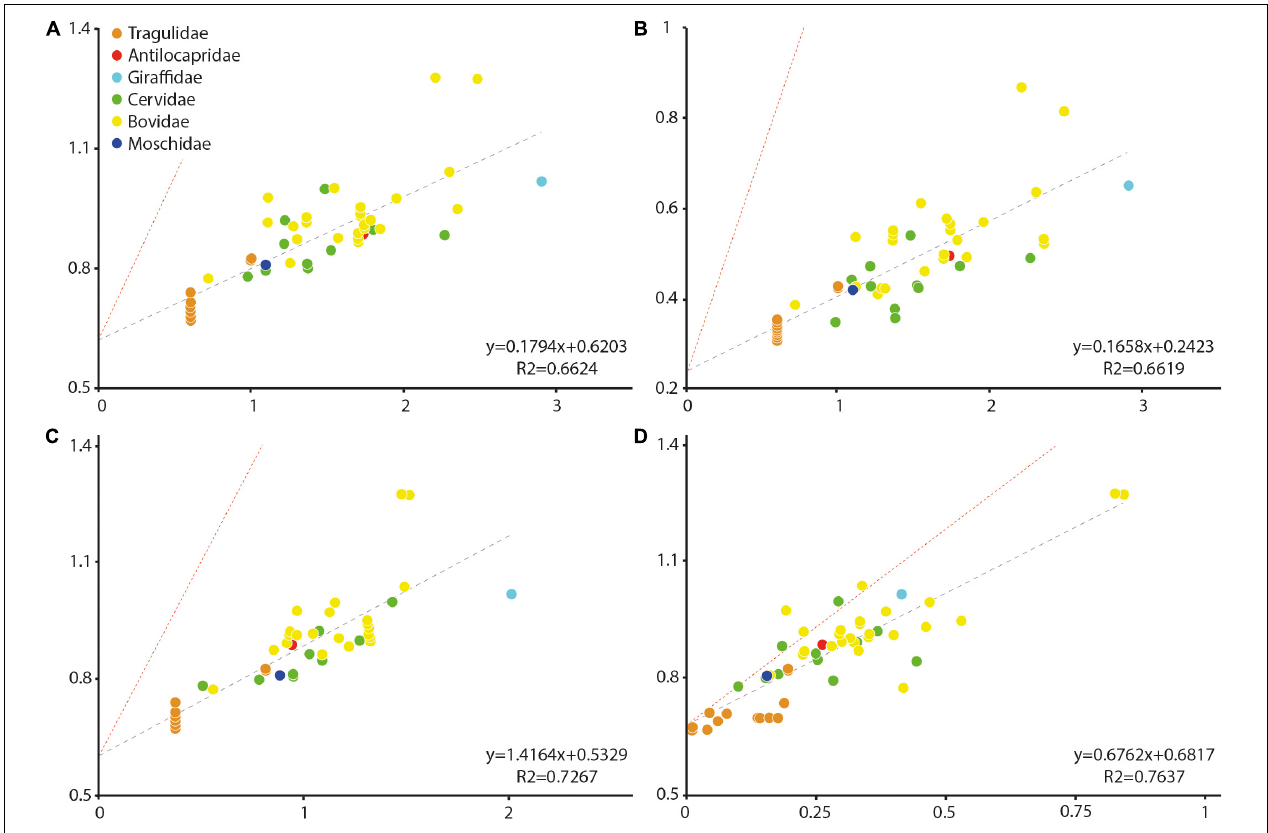
FIGURE 2 | Size allometry of the stapes structures in comparison to body mass in living ruminants, to other stapes structures, and to bony labyrinth length. (A) body mass against stapes centroid size; (B) body mass against the stapedial footplate centroid size; (C) bony labyrinth length against stapes centroid size; and (D) intercrural foramen centroid size against stapes centroid size. All values are in log. Antilocapridae red; Bovidae, yellow; Cervidae, green; Tragulidae, orange; Giraffidae, and light blue; Moschidae, dark blue. Red line corresponds to